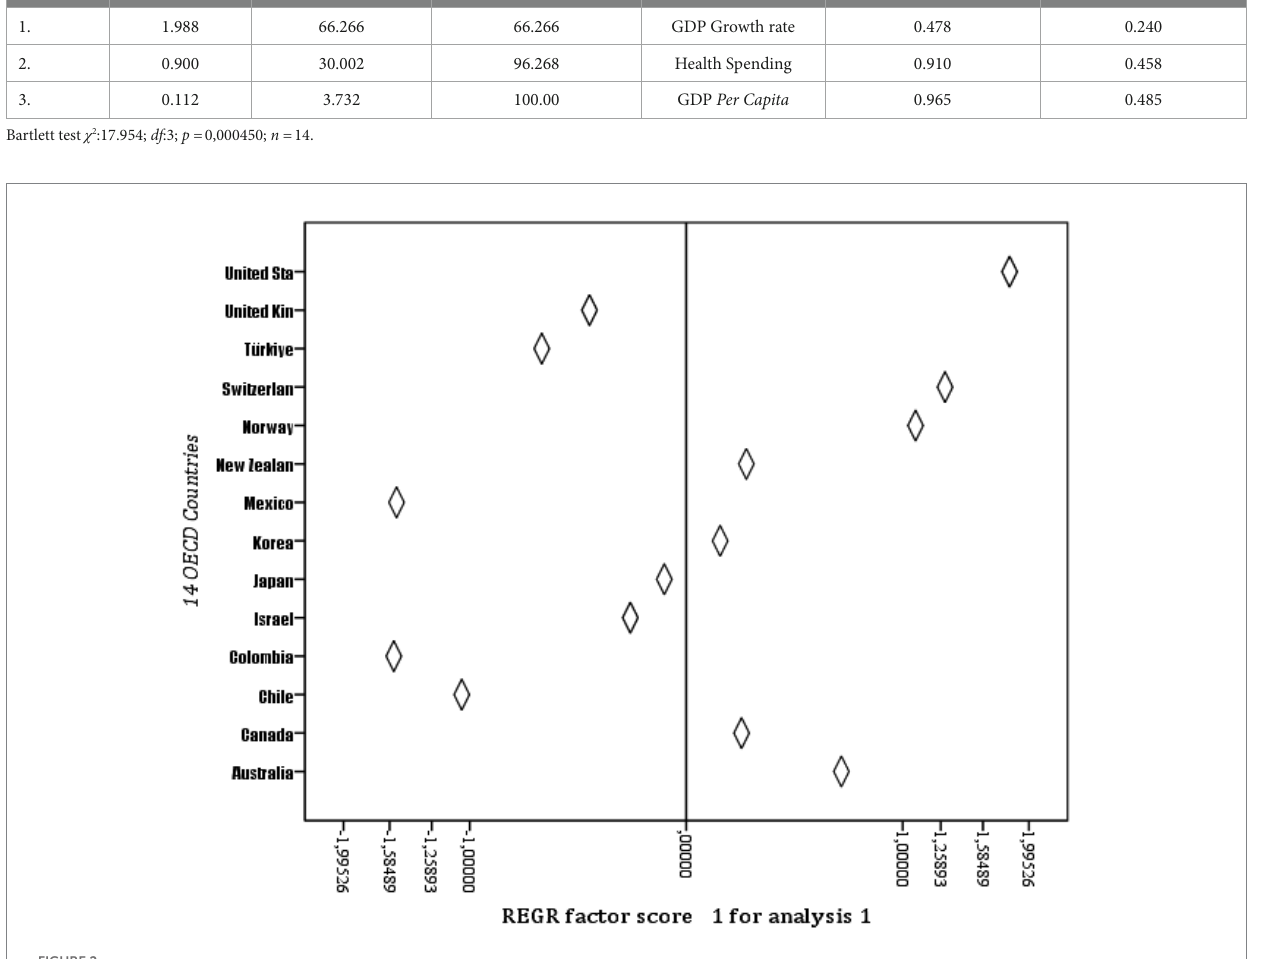
FIGURE 2 Logarithmic distribution of the observation values for the Factor_1 variable.